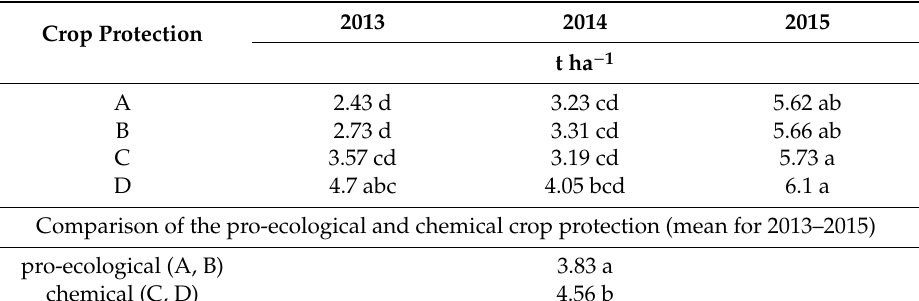
Table 5. The grain yield of the spelt wheat cv. “Rokosz”. The interaction between crop protection and years of research, and comparison of the pro-ecological and chemical crop protection. Di ff erent letters denote significant di ff erences ( p ≤